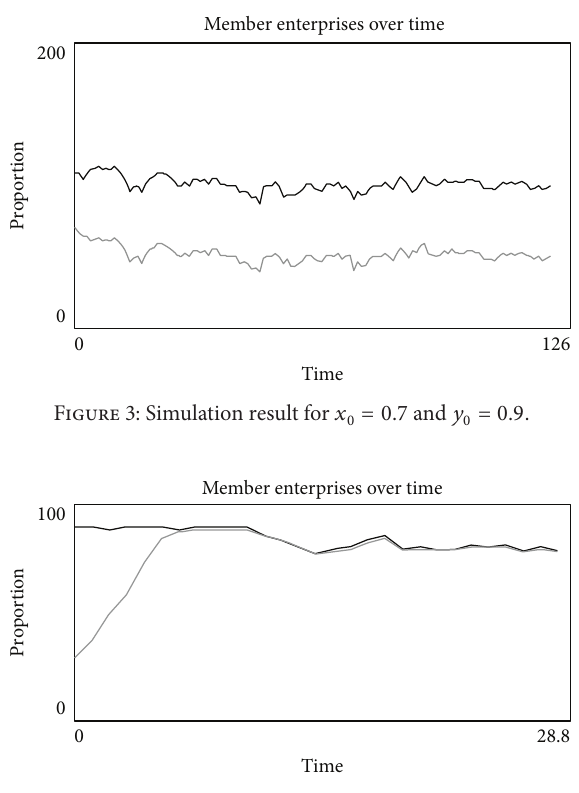
Figure 4: Simulation result for 𝑥 0 = 0.3 and 𝑦 0 = 0.9